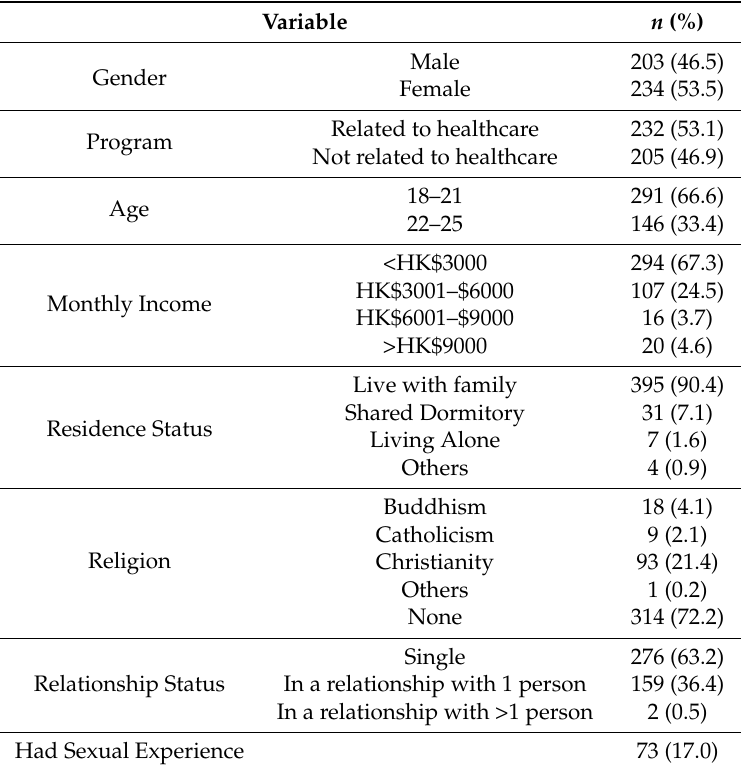
Table 1. Socio-demographic